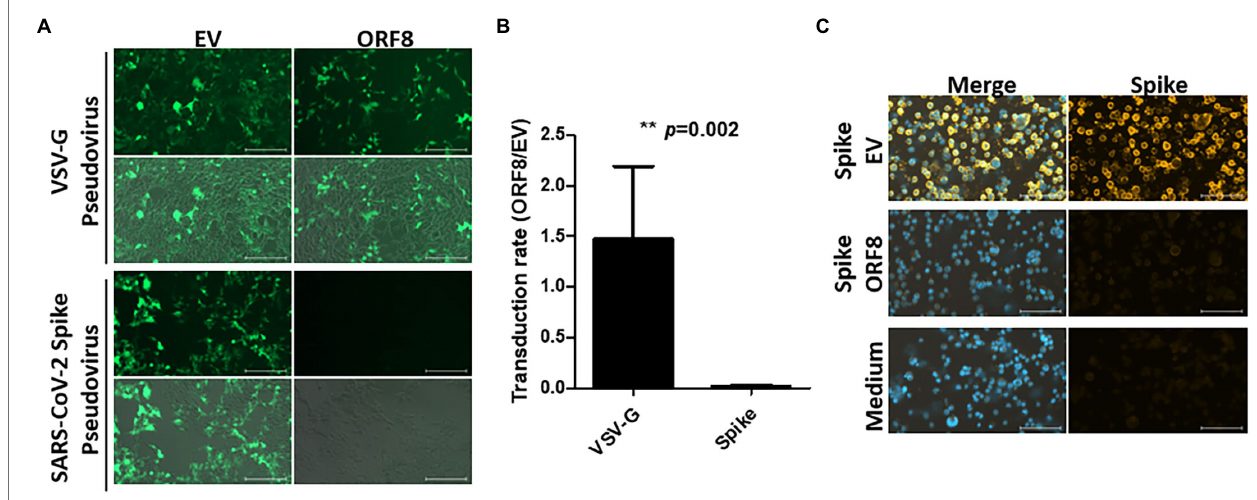
FIGURE 1 | ORF8 production abrogates the production of SARS-CoV-2 Spike pseudovirus. VSV-G and SARS-CoV-2 Spike pseudoviruses were produced in HEK293T cells by transfecting plasmids encoding Gag-pol or envelope protein (VSV-G or spike) and package plasmids encoding IRES-GFP (EV) or ORF8-IRES- GFP (ORF8). The same amount of viral supernatant from each sample were assayed to determine its transduction efficiency using HEK293T/hACE2 cells. The transduction efficiency were measured by fluorescence microscopy and flow cytometry 4 days after transduction. (A) Representative fluorescence microscopy data. For each result, the upper figure shows the GFP signal only and the lower figure shows the merged figure combined with the photo obtained by phase contrast. (B) The transduction rate of pseudoviruses prepared with ORF8 vs. control plasmids were quantified by flow cytometry from 5 independent experiments. (C) The purified Spike pseudoviruses were exposed to HEK293T/hACE2 cells on ice with rolling for 1 h. After extensive washes with PBS to remove the unbound viral particles, the bound viral particles were visualized using an antibody against the spike protein with a Cy3-labeled secondary antibody; DAPI were applied for nuclear staining. The data are shown as the means ± SDs (error bars). Student’s t -test was used, and p < 0.05 indicates a statistically significant difference; ** p < 0.01. The scale bar in (A) represents 200 μ m and in (C) represents 100 μ